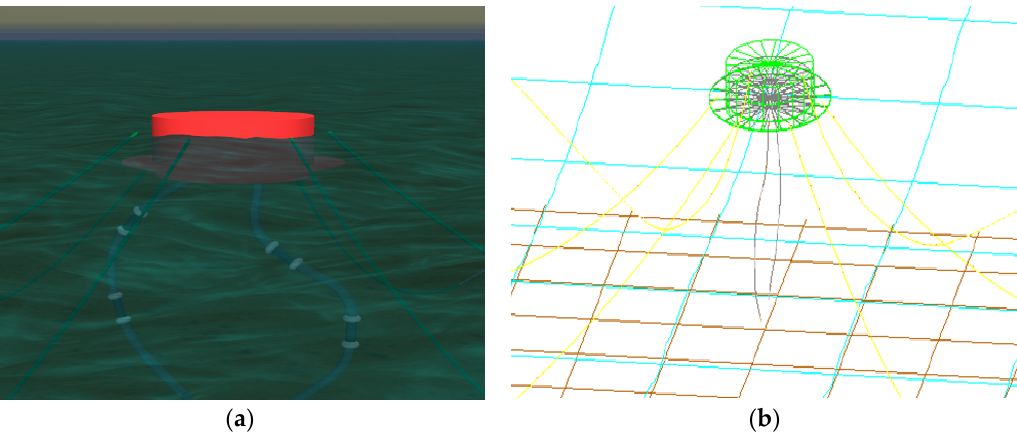
Figure 5. Numerical model of the CALM Buoy showing ( a ) shaded and ( b ) wireframe views.